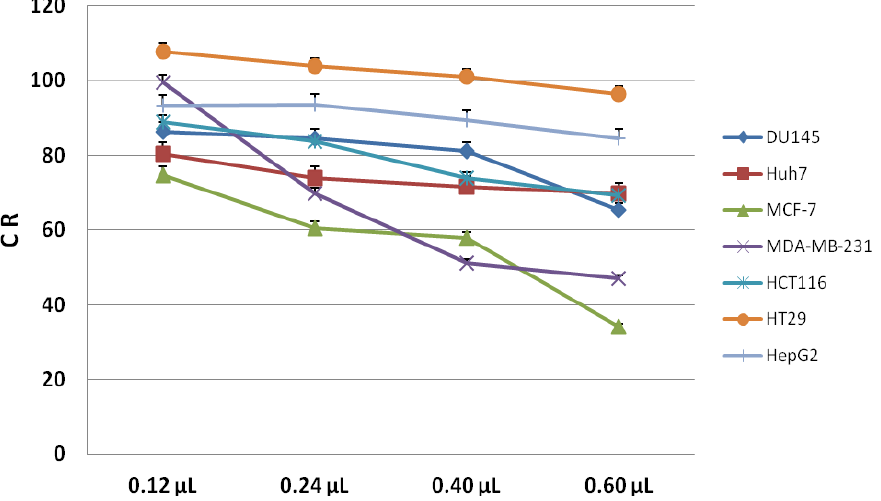
Figure 3. Cell lines growth curves (CR) after 24 h of treatment with hydrophylic extracts of PSO. In details, the viability percentages are reported as mean and standard deviation of triplicate